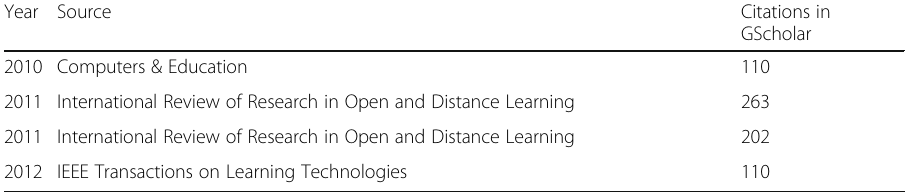
Table 2 Initial sample of work: year, source and number of citations in Google Scholar (Continued)